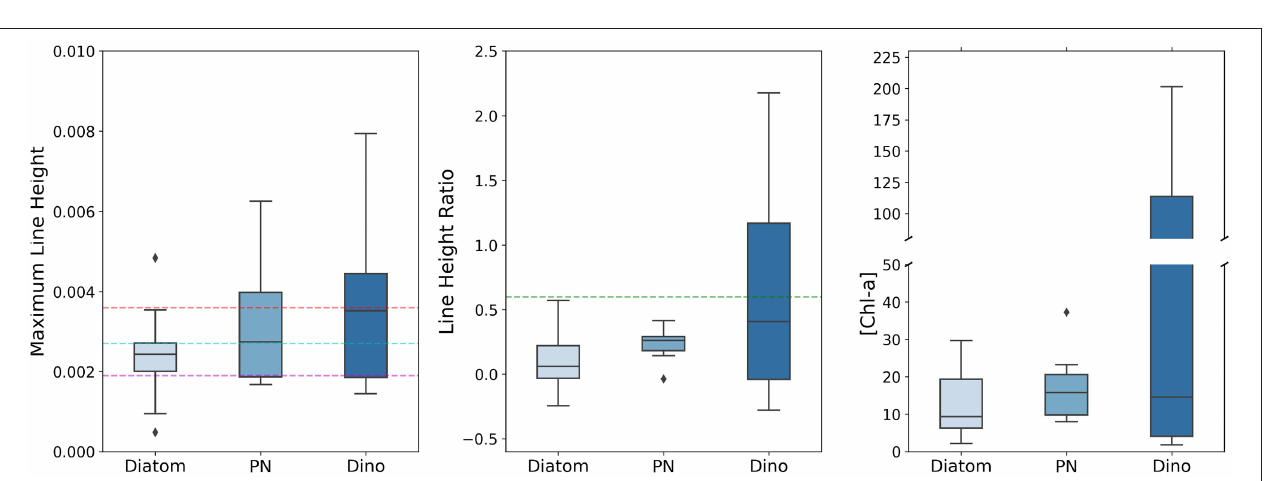
FIGURE 3 | Boxplots of the MLH, LHR, and [Chl-a] for samples with total cell concentration over 10 6 cells L − 1 . Each column represents the statistics associated with the dominance (i.e., > 50 % composition as relative abundance to the total cell count) of a given phytoplankton type, i.e., diatoms, Pseudo-nitzschia , and dinoflagellates. The horizontal lines of the boxes represent the 25th, 50th (median), and 75th percentiles, whereas the whiskers represent the valid minimum and maximum; outliers are indicated as diamonds. The colored dashed horizontal lines indicate the thresholds used in the initial probabilistic phytoplankton community